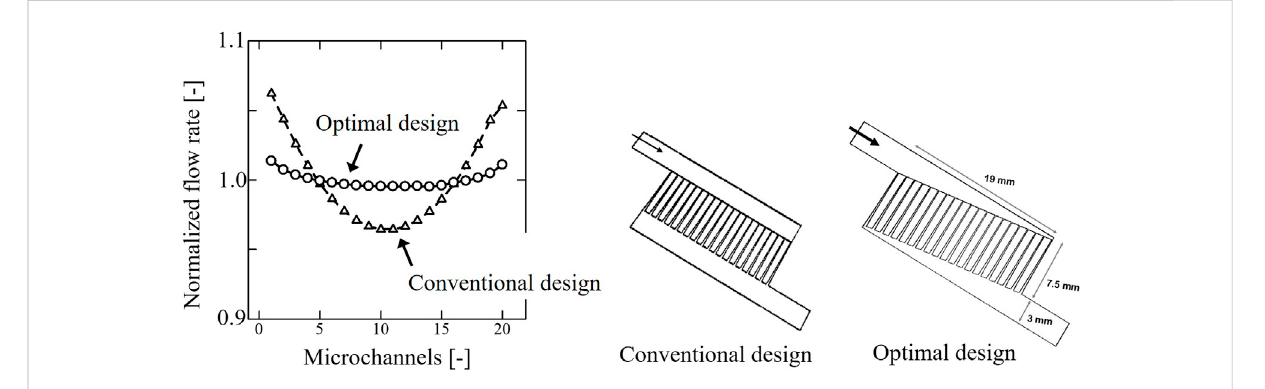
FIGURE 8 Fluid design results: fl ow uniformity (left) and reactor shape (right).